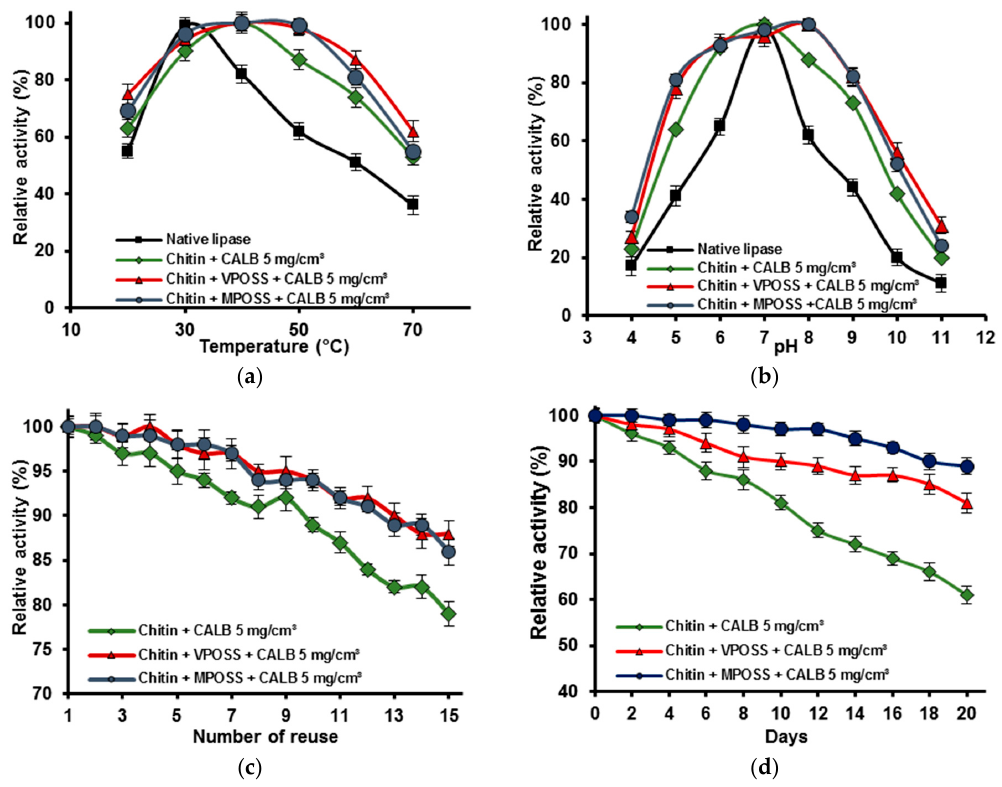
Figure 5. ( a ) Thermal stability; ( b ) effect of the pH; ( c ) reusability; and ( d ) storage stability of the immobilized lipase B from Candida antarctica . immobilized lipase B from Candida antarctica